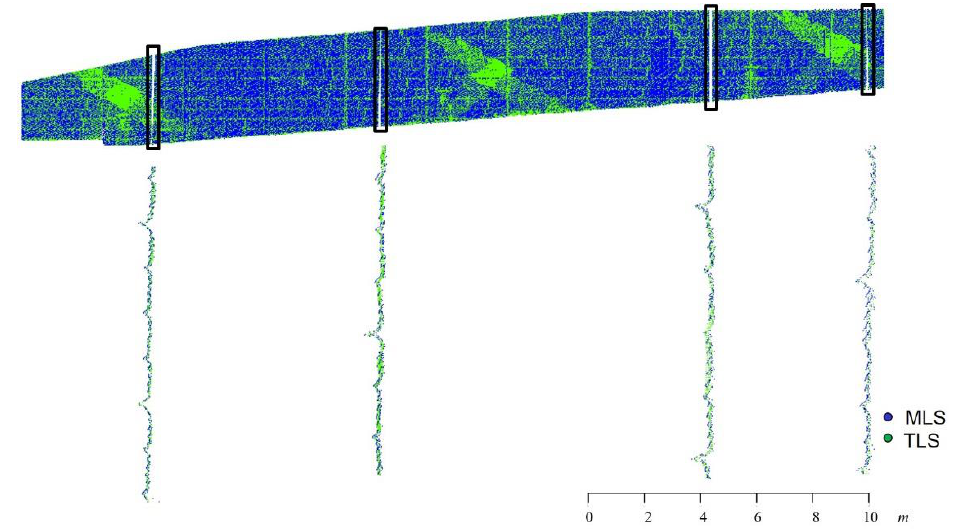
Figure 22. Cross sections illustrating the alignment quality of registered TLS scans of the MSE wall at Site-1.